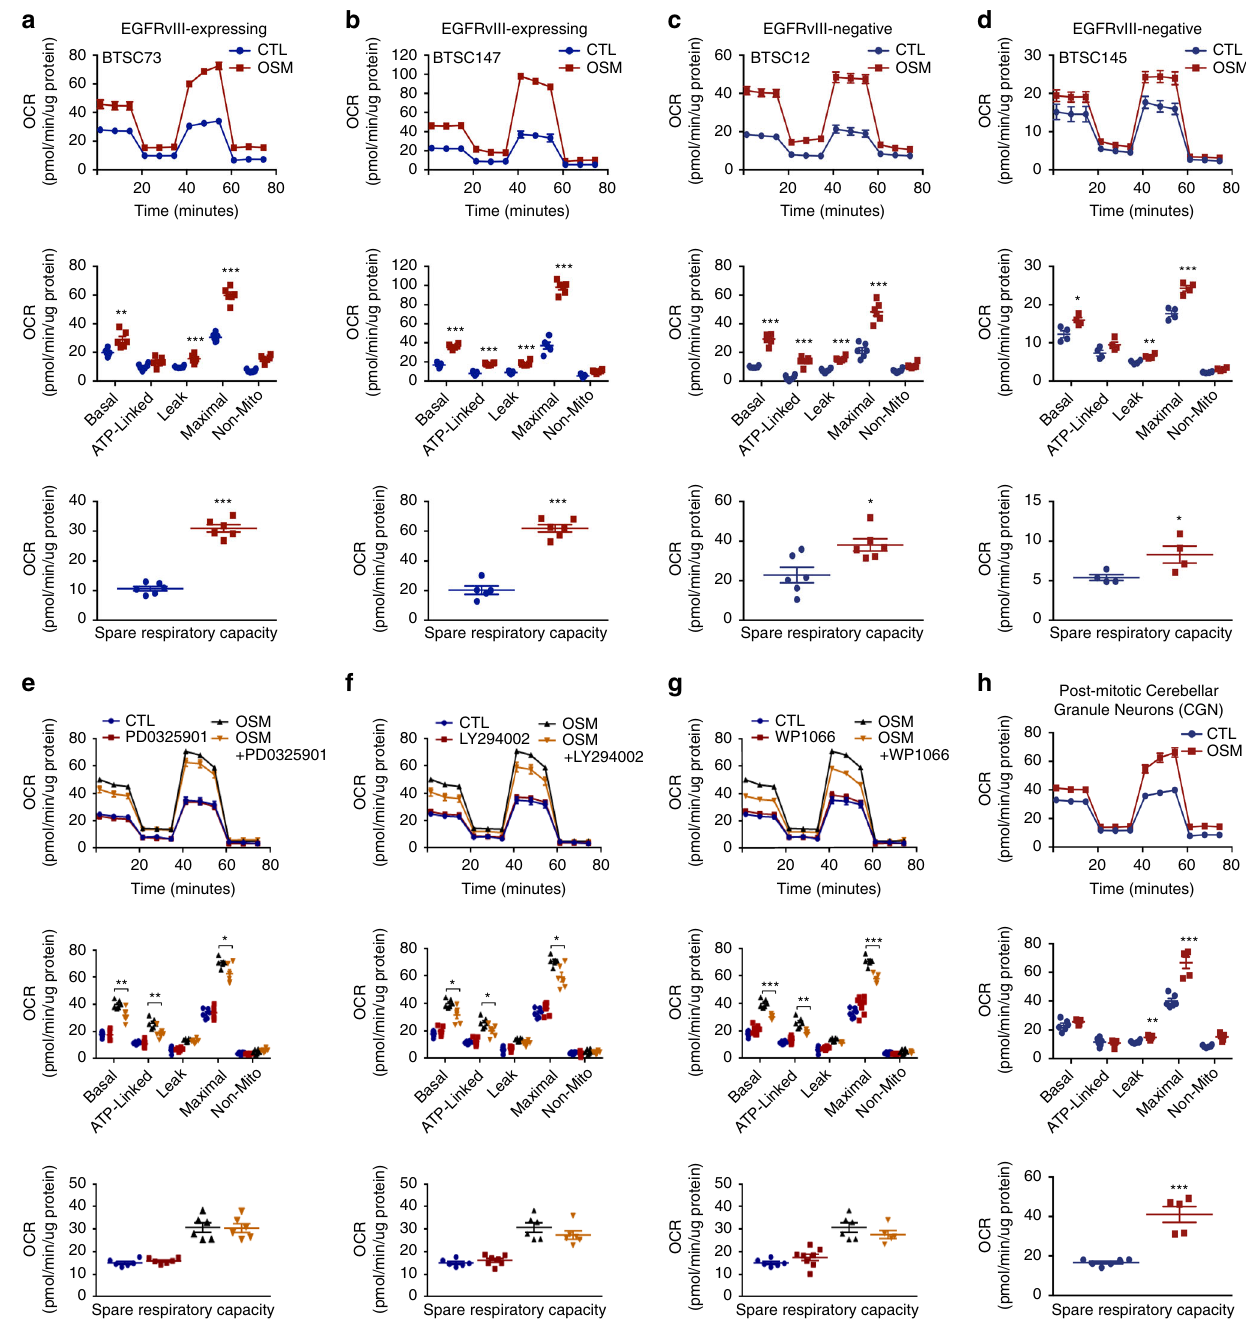
Fig. 4 The ligand OSM regulates mitochondrial OXPHOS. a , b Bioenergetic analysis using a Seahorse XFe96 Bioenergetic Flux Analyzer in the absence and presence of OSM was performed in EGFRvIII-expressing BTSCs. BTSC73 ( a ): *** p < 0.0001 for each pairwise comparison except: ** p Basal = 0.0045, *** p Leak = 0.0006; Unpaired two-tailed t -test, n = 6; BTSC147 ( b ): *** p < 0.0001 for each pairwise comparison; Unpaired two-tailed t -test, n ≥ 5. c , d Bioenergetic analysis in the absence and presence of OSM was performed in BTSCs lacking the EGFRvIII mutation. BTSC12 ( c ): *** p < 0.0001 for each pairwise comparison except: * p SRC = 0.0124; Unpaired two-tailed t -test, n = 6; BTSC145 ( d ): * p Basal = 0.0179, * p SRC = 0.0435, ** p Leak =